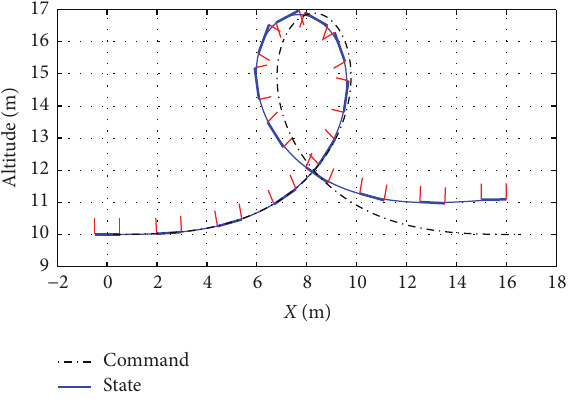
Figure 13: Quadcopter visualisation with PD